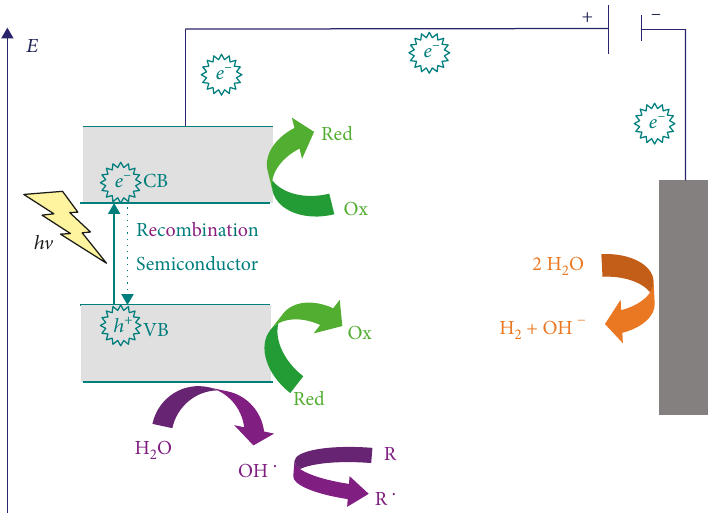
Figure 8: Scheme of electrochemical assisted